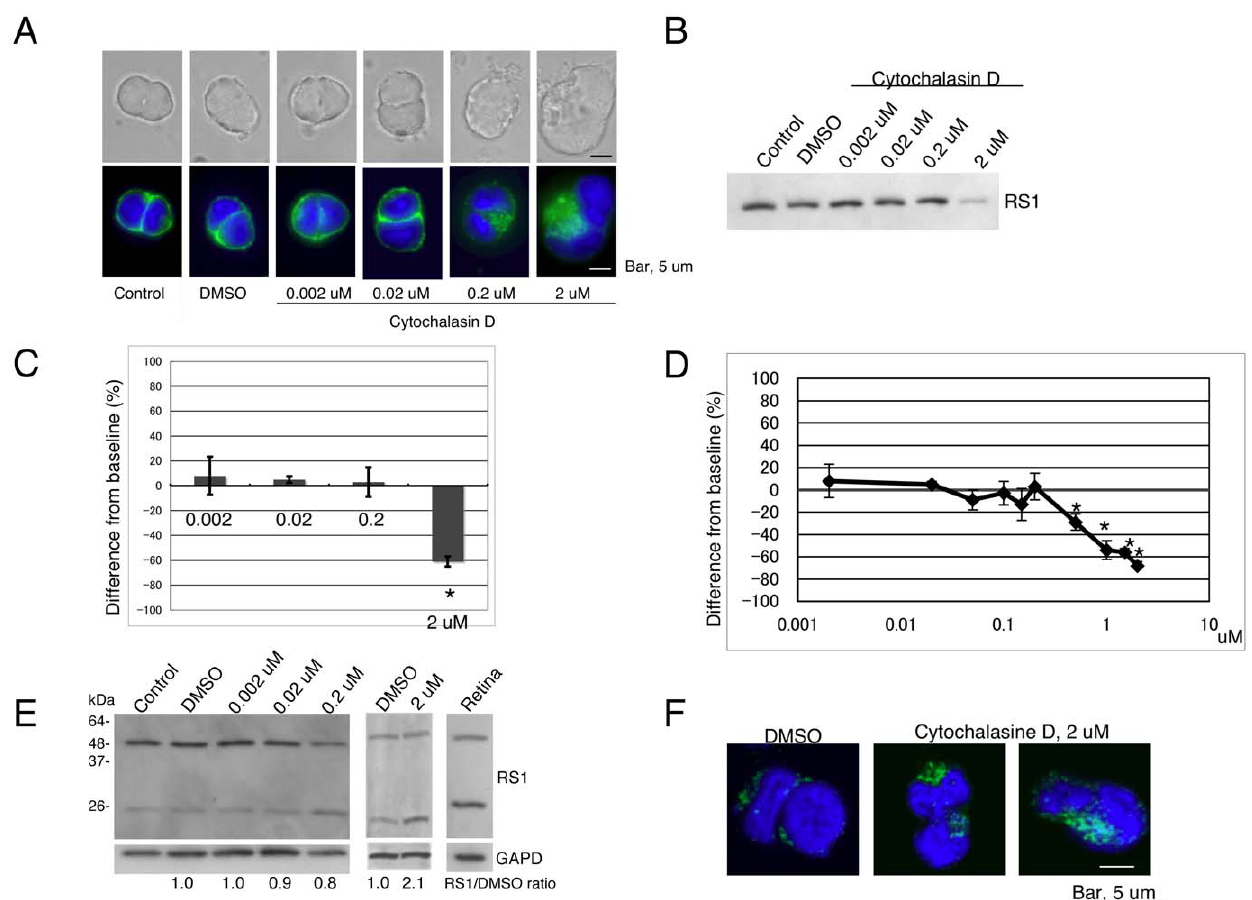
Figure 2. Retinoschisin secretion into the conditioned medium is decreased by addition of cytochalasin D. (A) Effects of cytochalasin D on cell morphology and F-actin cytoskeleton organization are dose dependent. Weri-Rb1 cells were cultured for 72 h in medium alone (untreated control) and medium containing DMSO or the indicated concentrations of cytochalasin D. Cells were then fixed, labeled with Alexa Fluor 488- phalloidin (green) and DAPI, and examined for changes in F-actin cytoskeleton organization. The upper row of pictures shows transmitted light images and the lower row, fluorescent light images. Bar, 5 m m. (B) Retinoschisin secretion into the conditioned medium decreases by treatment of cells with 2 m M cytochalasin D. Cells were treated as in (A) for 72 h. The medium for each condition was analyzed by Western blot using the RS24-37 antibody against retinoschisin. (C) Quantification of the intensity of each band on the Western blot in (B) (see MATERIALS AND METHODS). The data are means 6 standard error of the mean (SEM) of three biological samples analyzed for each condition. (*) indicates that a p , 0.05 was obtained for the difference between 2 m M cytochalasin D- and DMSO-treated cells. (D) Retinoschisin secretion decreases in a dose-dependent manner by treatment of cells with cytochalasin D at concentrations between 0.5 m M and 2 m M. Retinoschisin secretion was examined in the media of cells treated with cytochalasin D concentrations in the range of 0.02 to 2 m M as in (B) and quantified as stated in (C). (E) Retinoschisin level in the whole cell lysate increases with 2 m M cytochalasin D treatment. After 72 hr incubation in medium alone, medium containing DMSO or the indicated concentrations of cytochalasin D (left and middle panels) the cells were collected and analyzed by Western blot. Both the monomer and dimer of retinoschisin were detected in the retinal lysate (right panel). The intensities of the dimer and monomer bands for each sample were added and normalized to GAPDH. The normalized results were compared to the values obtained for the cells incubated in medium containing only DMSO and are shown as RS1/DMSO ratios. (F) Retinoschisin accumulates within cells treated with 2 m M cytochalasin D. Cells were treated with DMSO or 2 m M cytochalasin D for 72 h. Cells were then fixed and incubated with RS24-37 antibody, followed by Alexa Fluor 488 goat anti-rabbit IgG. Nuclei were labeled with